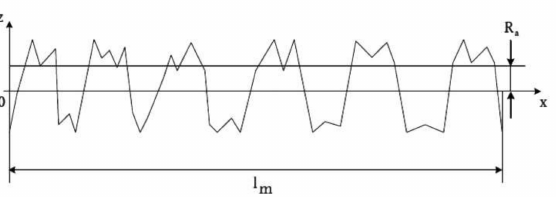
Figure 6. Presentation and calculation of the arithmetic average roughness Ra. Ra shows the roughnesses in the z -axis, peaks and grooves are measured, time is represented on the x -axis. These equal distances correspond to the length of the cut-off wavelength (Figure 7).